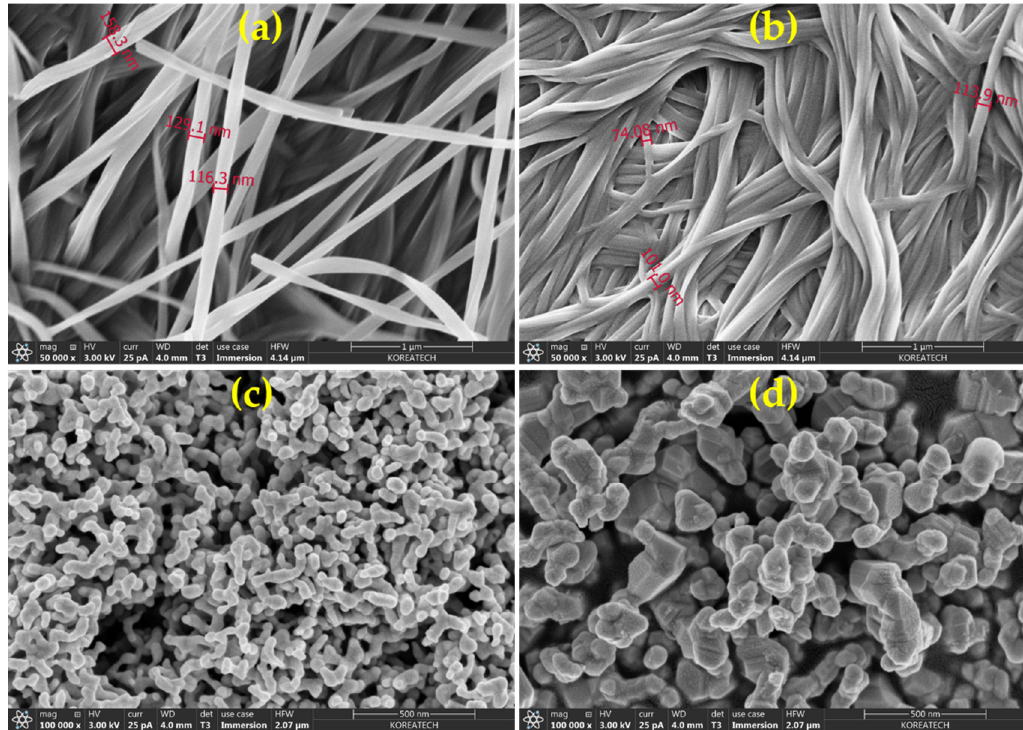
Figure 4. FESEM micrographs of ( a & b ) PC-X1 and PC-X2, respectively (Scale = 1 µ m); ( c & d ) SNC- PC-X1 and SNC-PC-X2, respectively (Scale = 500 nm).